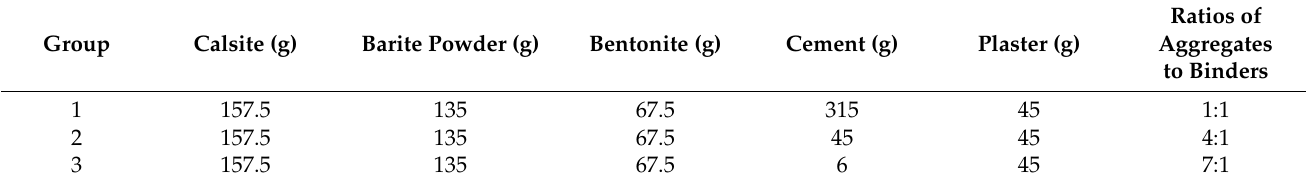
Table 3. Materials used to make the test